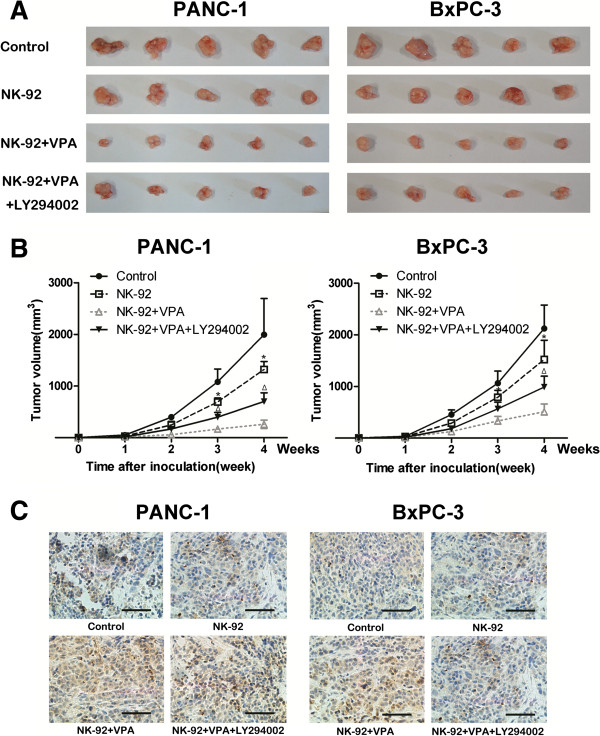
VPA sensitizes pancreatic cancer cells to NK cell-mediated lysis in vivo by upregulating the expression of MICA and MICB. (A, B) Excised xenograft tumors and growth curves for the xenografts; VPA enhanced the growth inhibitory effect of NK cells in vivo; this effect was attenuated by the PI3K inhibitor LY294002. Data are mean ± SD of five mice per group; * P < 0.05 for NK-92 vs. NK-92 + VPA; Δ P < 0.05 for NK-92 + VPA + LY294002 vs. NK-92 + VPA. (C) Immunohistochemical staining and quantification of MICA and MICB expression in the xenograft tumors; VPA significantly upregulated the expression of MICA and MICB in the pancreatic cancer xenograft tumors in vivo, this effect was attenuated by the PI3K inhibitor LY294002.